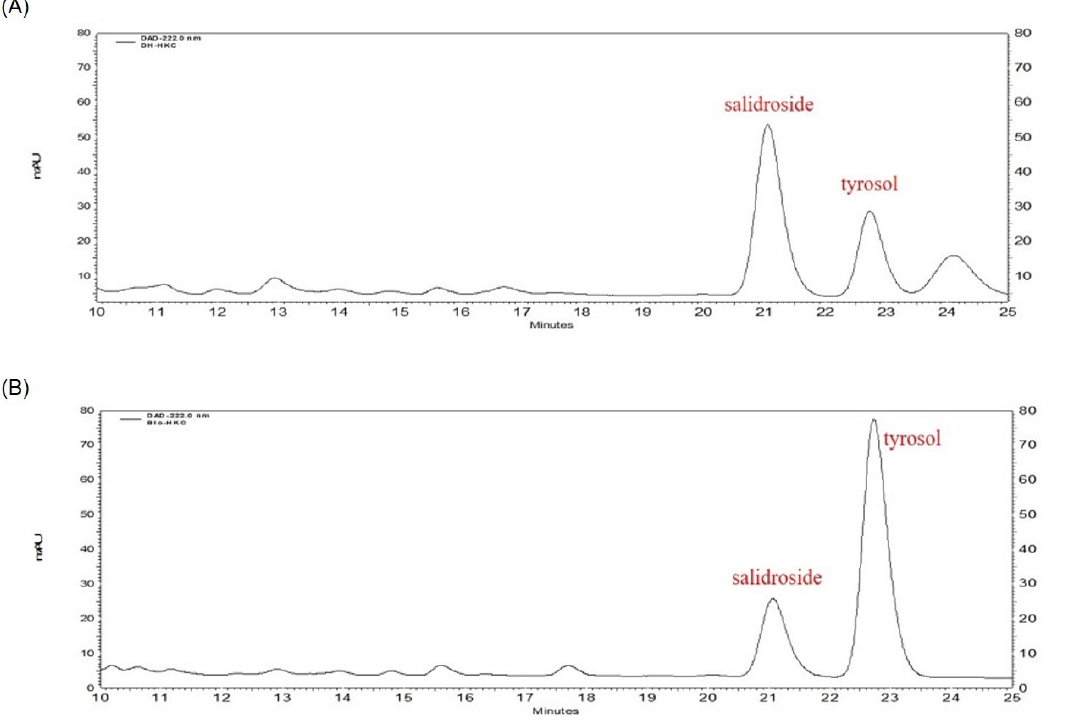
Figure 1. Representative HPLC chromatograms of R. sachalinensis extract fermented with Bovista plumbea (Bio ‐ RSE) and R. sachalinensis extract (RSE). Chromatograms ( A , B ) show the contents of tyrosol and salidroside in the RSE and Bio ‐ RSE, respectively.